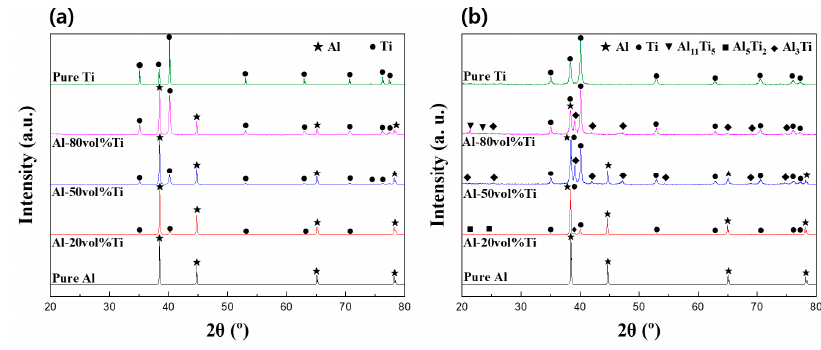
Figure 5. XRD patterns of ( a ) powders and ( b ) composites. Table 1. The physical properties of Al, Ti, and Al-Ti composites.